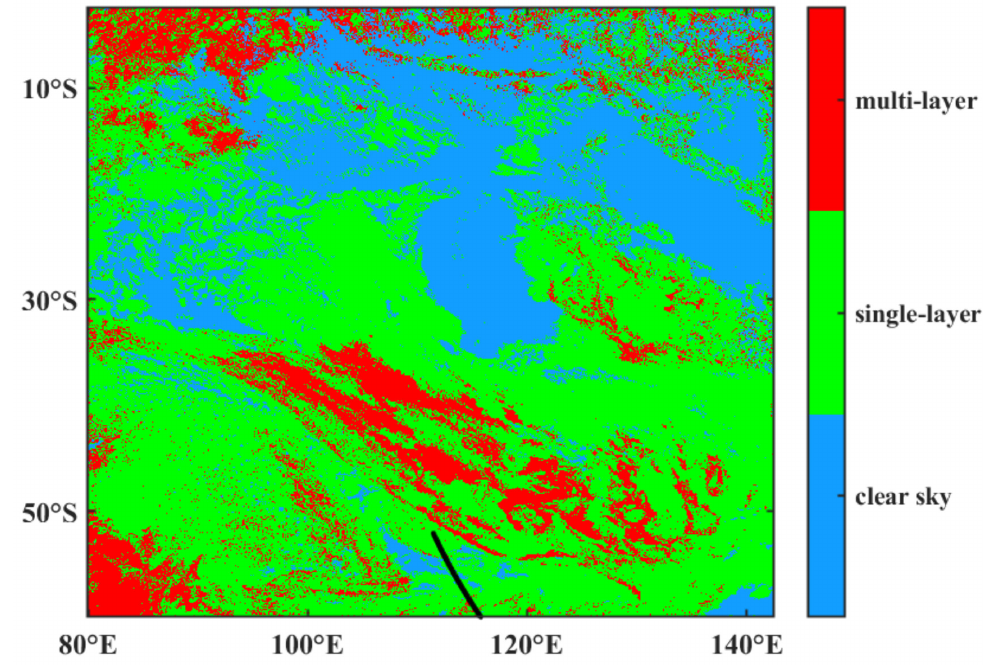
Figure 5. Multi-layer cloud detection from 5 October 2017 at UTC 07:00. The blue, green, and red pixels represent clear sky, single-layer clouds, and multi-layer clouds,